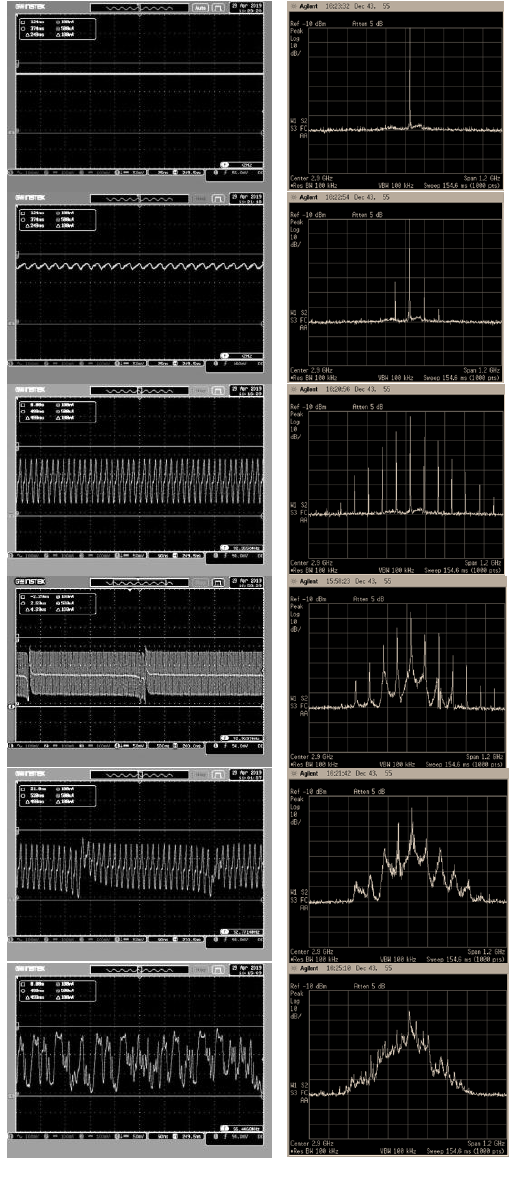
Fig. 5. Envelopes and spectra of output signal while reducing losses of coupling channel at oscillators frequencies detuning 20-30 transition to chaos occurs more rigidly (Fig. 6). With decreasing losses the process of intermittency is practically absent. In the initial state (upper pictures), the system with a high degree of periodicity generates auto-transitions between in-phase and complex modulated oscillations. Therefore, the spectrum has a high level of discrete components.